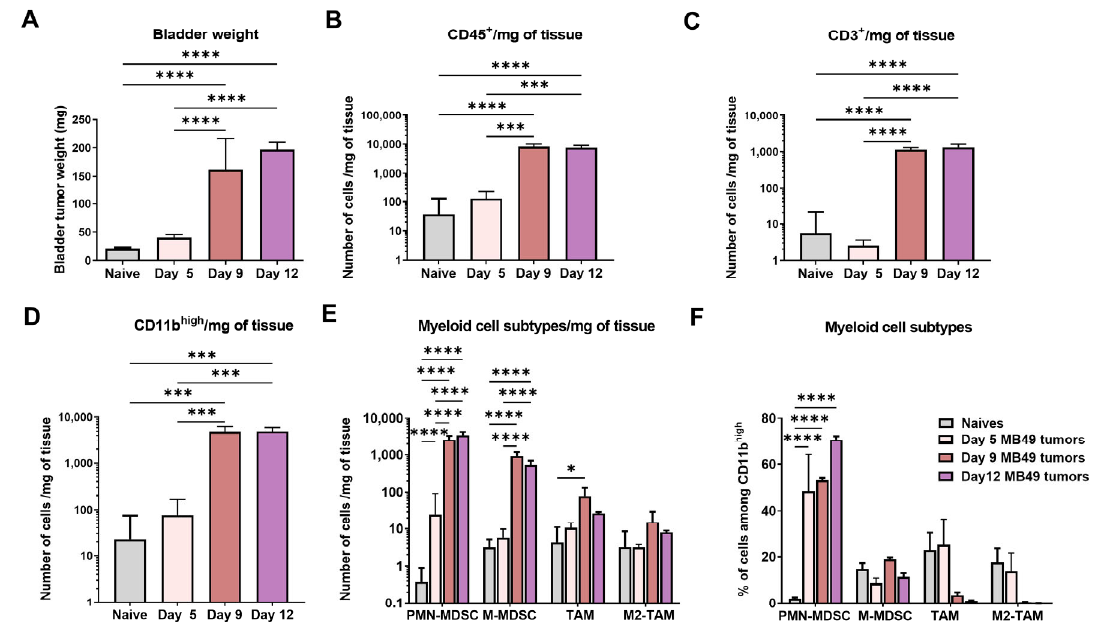
Figure 1. Characterization of the immune infiltration in MB49 bladder tumors. MB49-luc cells were intravesically instilled in the mouse bladder at day 1. Mice were then sacrificed at different time points (day 5 ( n = 10), day 9 ( n = 4) or day 12 ( n = 4)). Naïve mice ( n = 4) are shown as control. Bladder weight at each time point (mean ± SEM) is shown ( A ). Tissue-infiltrating immune cells were analyzed by flow cytometry. Absolute numbers per mg of tissues of CD45 + cells ( B ), T cells (CD3 + , ( C )), myeloid cells (CD11b high , ( D )) and myeloid cell subtypes segregated as PMN-MDSC (Cd11b high Ly6G high ), M-MDSC (CD11b high Ly6C high ), TAM (CD11b high Ly6C low Ly6G low F480 + and M2-TAM (CD11b high Ly6C low Ly6G low F480 + CD206 + ) ( E ). Myeloid cell subtypes are shown as percentages among CD11b high cells ( F ). Significant differences are shown after one-way ANOVA followed by a Tukey’s comparison test **** = p < 0.0001 or *** = p < 0.001 or * = p <